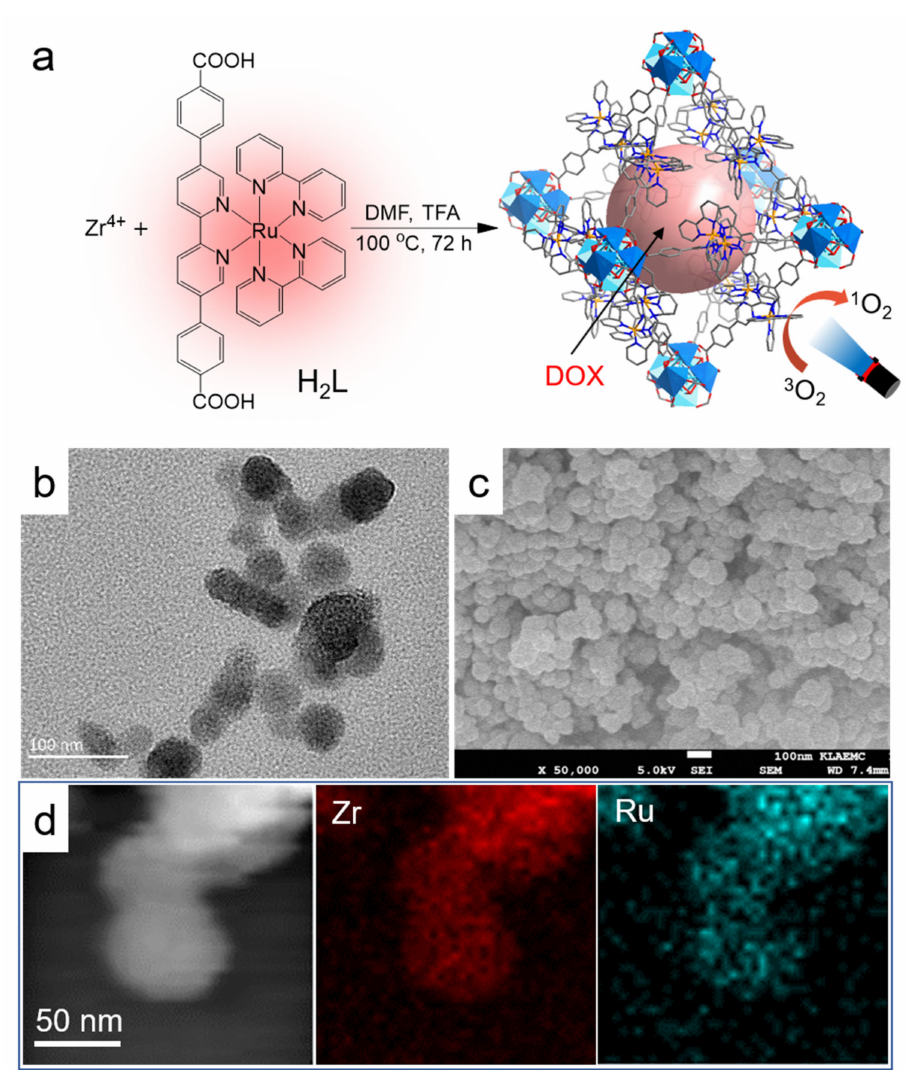
Figure 1. Structure and chemical composition analysis of H 2 L-MOF nanoparticles. ( a ) The schematic illustration of the synthesis of H 2 L-MOFs, uptake of drug for chemotherapy, and the processes of light-triggered singlet oxygen generation for PDT. ( b )TEM image, ( c ) SEM image, and ( d ) STEM image and EDS elemental mapping of H 2